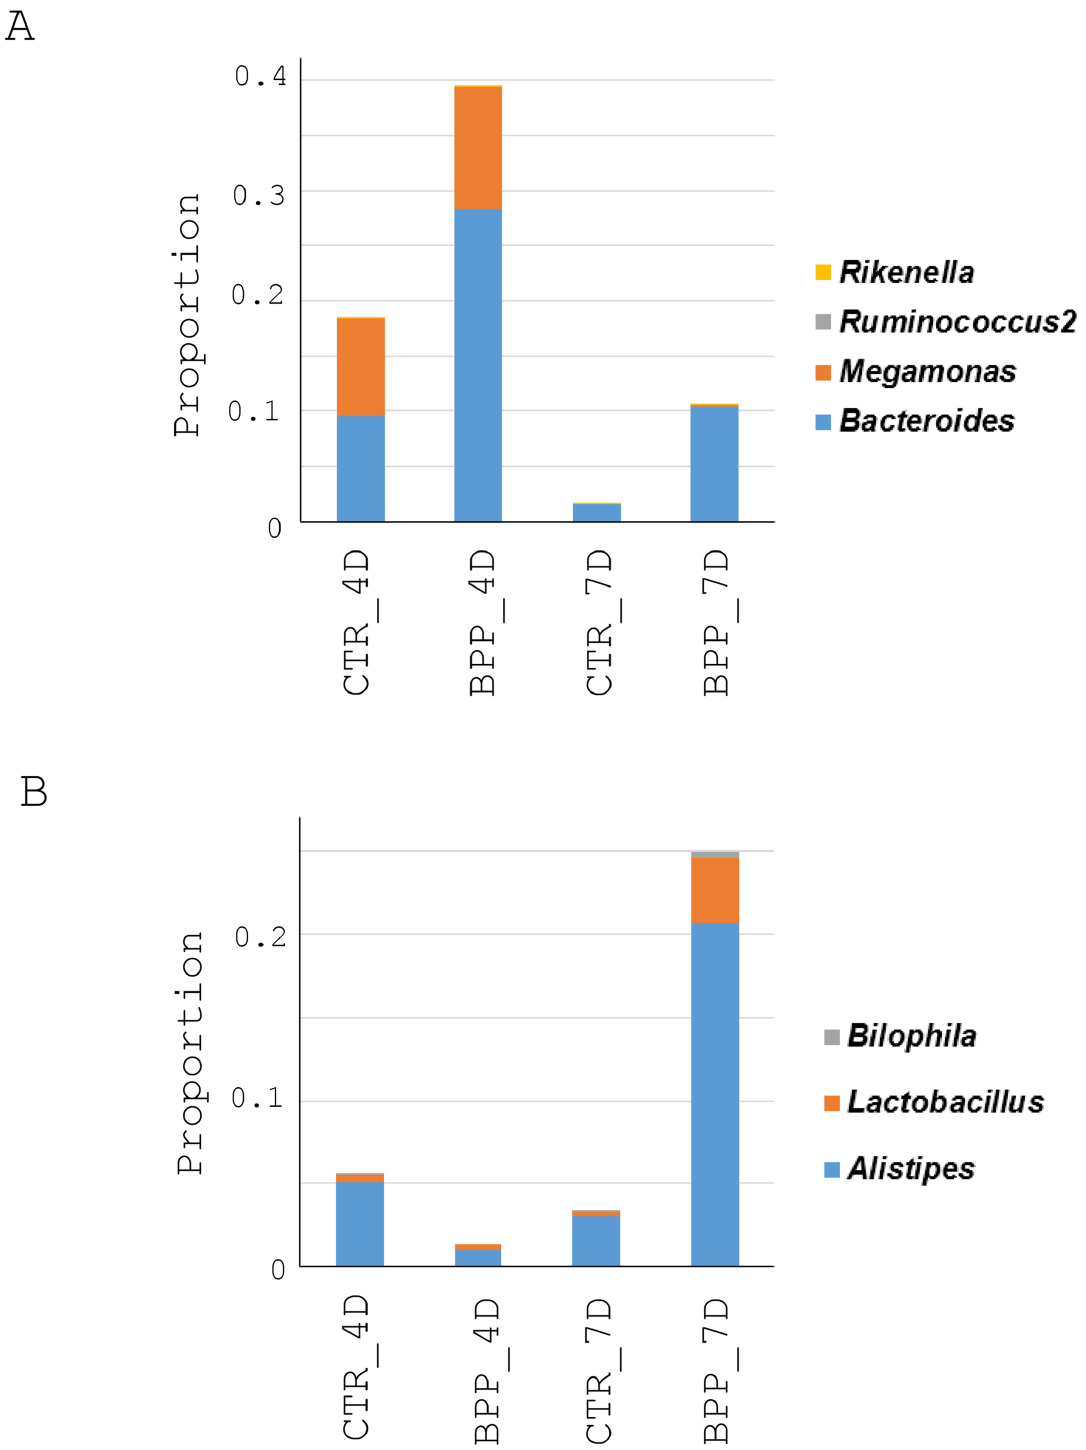
Fig 6. Change in the proportion of the probiotic bacterial genera in the guts of chickens fed with or without B . pilosa . The bacterial genera increased in proportion in the guts of the non-infected chickens by B . pilosa ( Fig 2), were re-plotted into histograms. Only the data obtained from CTR_4D, BPP_4D, CTR_7D and BPP_7D are shown. Two patterns of change in the proportions of the bacterial genera are presented in Fig 6A and 6B. The genera in Fig 6A were increased in 18-day-old chickens whereas those in Fig 6B were increased in 21-day-old chickens.